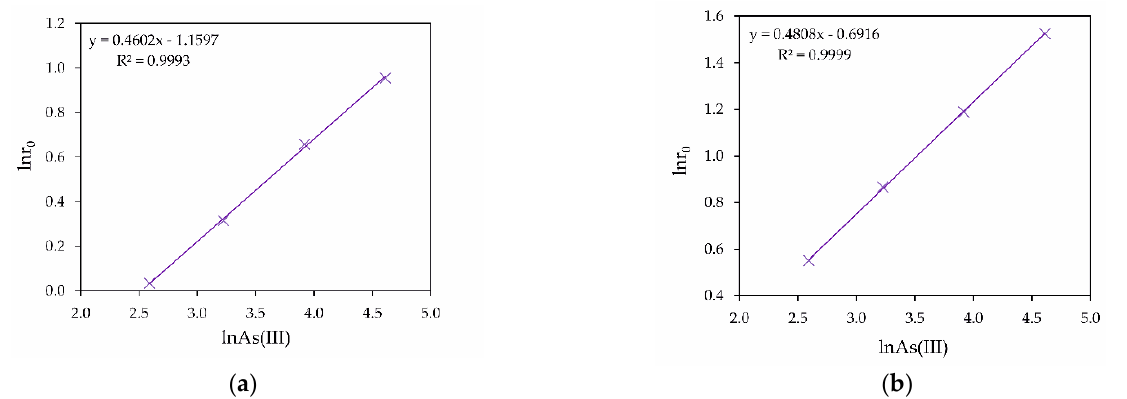
Figure 11. Dependences of lnr 0 on lnAs (III) without ( a ) and with ( b ) Cu (II). To derive a general kinetic equation, we plotted all temperatures, concentrations, and oxygen pressures, which allowed the fixed slope angle of a = 1.08 to be determined. The “a” value obtained by the graphical method and the corresponding correlation coefficient R 2 are presented in Figure 12 for the H 3 AsO 3 -Fe 2 -H 2 SO 4 and H 3 AsO 3 -Fe 2+ -Cu 2+ -H 2 SO 4 systems. The obtained value of the “a” coefficient corresponds to k o . Some kinetic data at different parameters for oxidation efficiency of As (III) to As (V) are shown in Table 2.